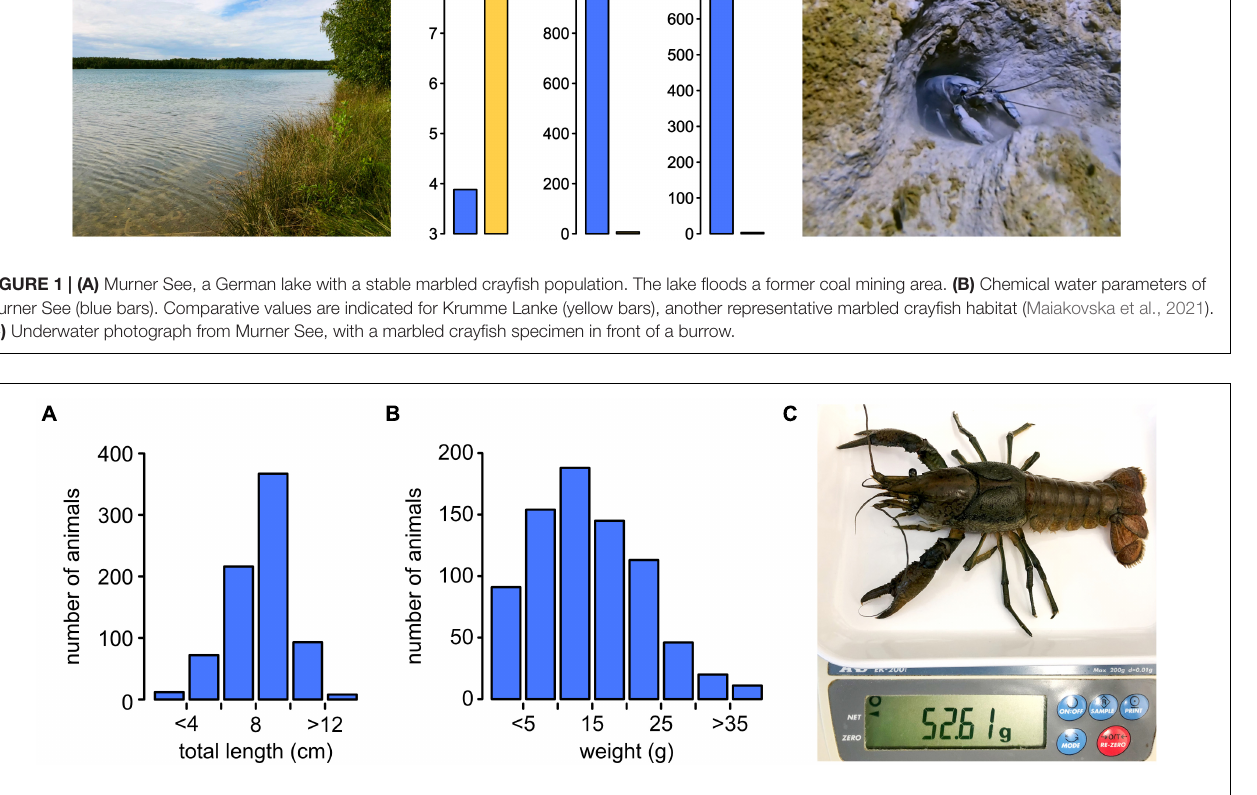
FIGURE 2 | Size and weight of marbled crayfish. (A) Total length distribution of 768 marbled crayfish collected at Murner See. (B) Weight distribution of 768 marbled crayfish collected at Murner See. (C) A wild-caught and laboratory-reared specimen with a total length of 13.2 cm, and a weight of 52.61